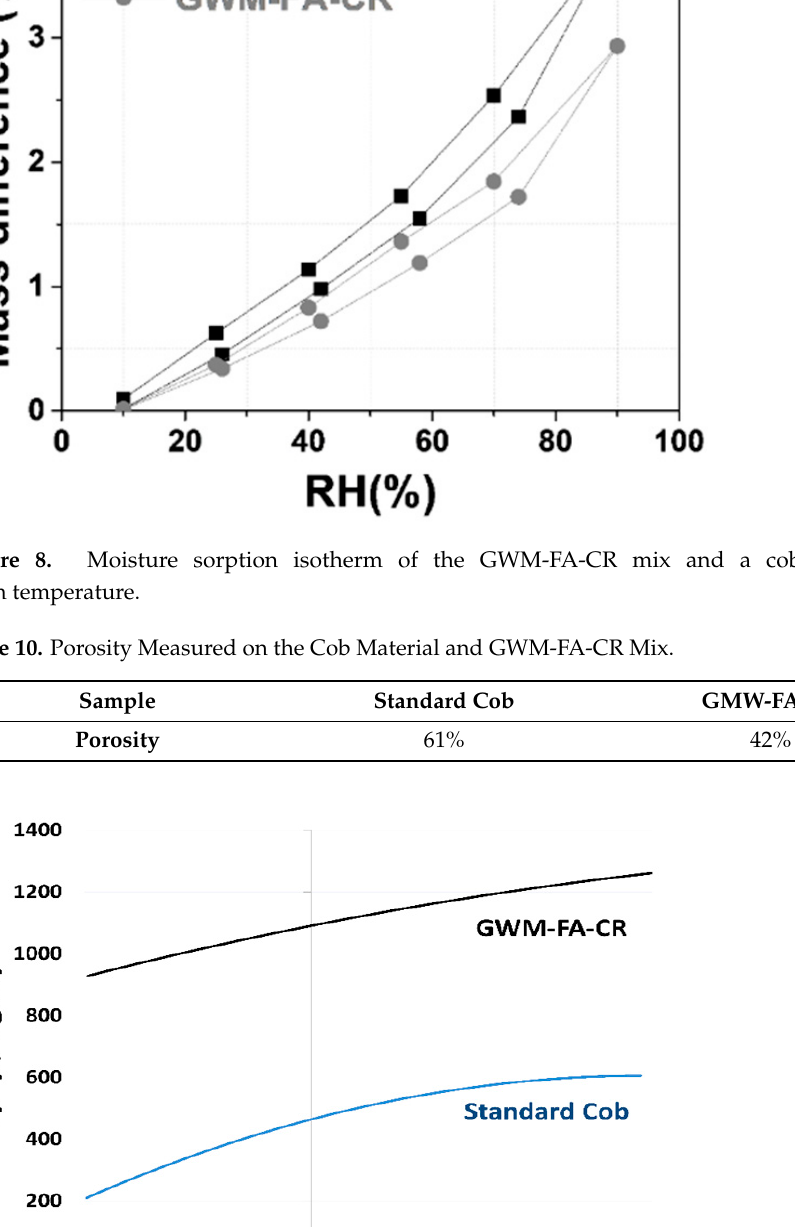
Figure 8. Moisture sorption isotherm of the GWM-FA-CR mix and a cob material at room tempera- ture. Table 10. Porosity Measured on the Cob Material and GWM-FA-CR Mix. Sample